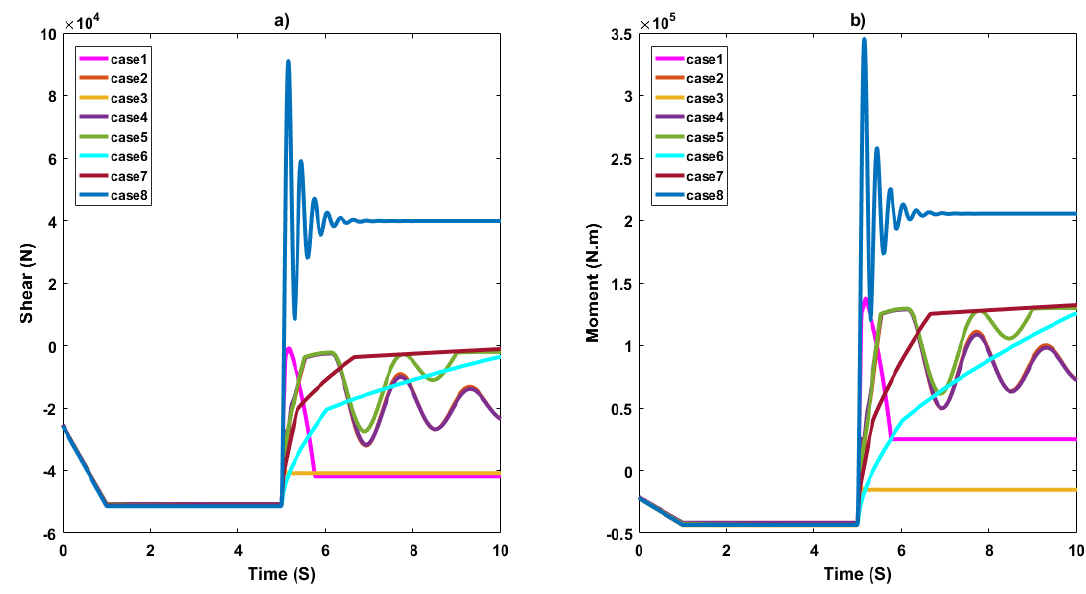
Figure 18. Beam behavior after column removal in story one: ( a ) shear and ( b ) moment.